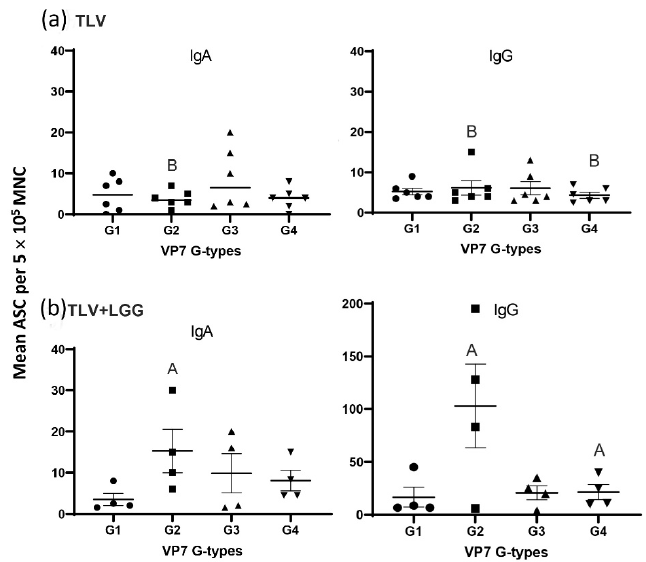
Figure 5 . IgA and IgG VP7 G-type-specific ASC responses in the ileum at challenge (PID 28/PCD 0) in ( a ) pigs orally immunized with TLV vaccine, and ( b ) pigs immunized with TLV vaccine in the presence of LGG. The ASC responses to different VP7 G-types were statistically similar within each vaccine group (Kruskal–Wallis non-parametric rank sum test, p < 0.05). Mean in the same column with different capital letters indicates significant differences between the TLV and TLV+LGG groups for the same G type. Lines and error bars represent the mean and SEM. When analyzing the IgA and IgG VP7-specific ASC responses pre- and post-chal- lenge with the G1P[8] virulent Wa HRV in intestinal (ileum) and systemic lymphoid tis- sues (spleen and blood) (Figure 6), the IgA responses were mainly detected in the ileum, corresponding to the replication site of the vaccine, whereas IgG responses were detected in both intestinal and systemic lymphoid tissues. There were no or very low IgA and IgG ASC counts in the spleen and blood for both vaccinated groups at PID 28/PCD 0. The LGG adjuvant significantly increased the number of G2 VP7-specific IgA and IgG ASC in the ileum and G4 VP7-specific IgG ASC in the ileum when compared with the pig receiving the vaccine alone pre-challenge. Post-challenge, both vaccinated groups developed strong anamnestic IgA and IgG responses in the ileum, with higher or significantly higher num- bers of ASC at PCD 7 compared to PCD 0 for all the four VP7 G-types. The TLV + LGG pigs developed significantly higher IgG ASC responses to all four VP7 types in the spleen and blood than the TLV pigs at PCD 7. Overall, the ASC responses induced by the TLV vaccine were enhanced or significantly enhanced by the concurrent administration of LGG, in all tissues tested and at both timepoints, not only for all the VP7 G-types present in the vaccine, but also for the heterotypic G1P[8] HRV used for the challenge (Figure 6).